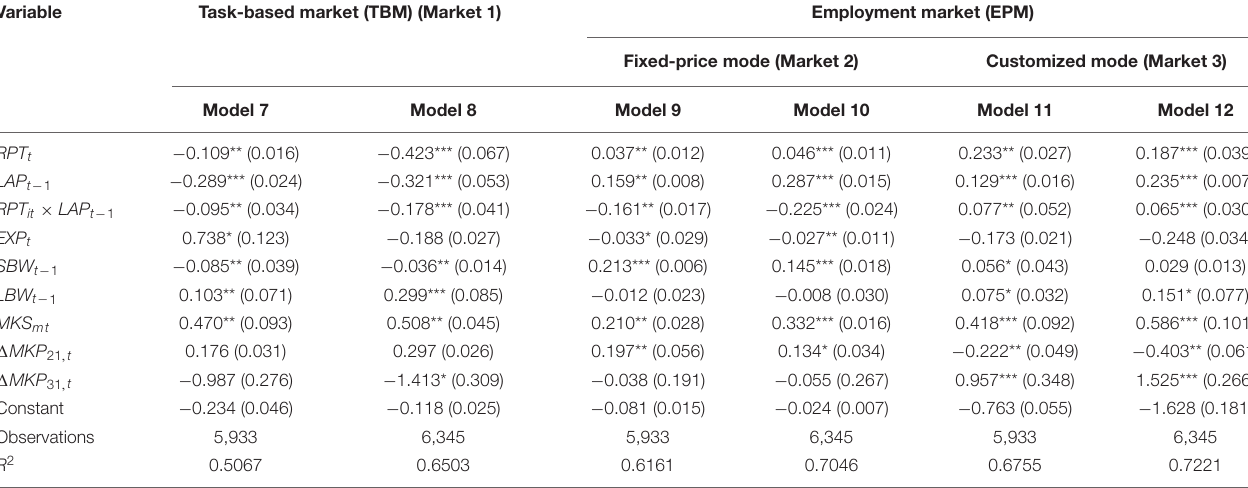
TABLE 6 | Robustness